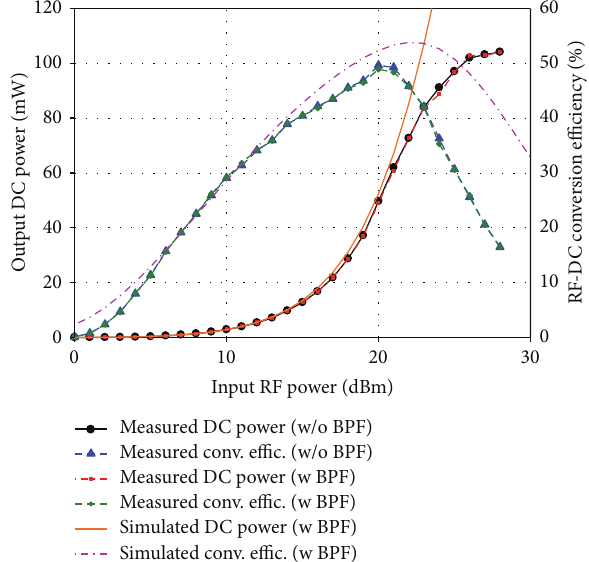
Figure 6: Simulated and measured DC output power and rectifica- tion efficiency of the fabricated rectifier using a 5.8 GHz CW